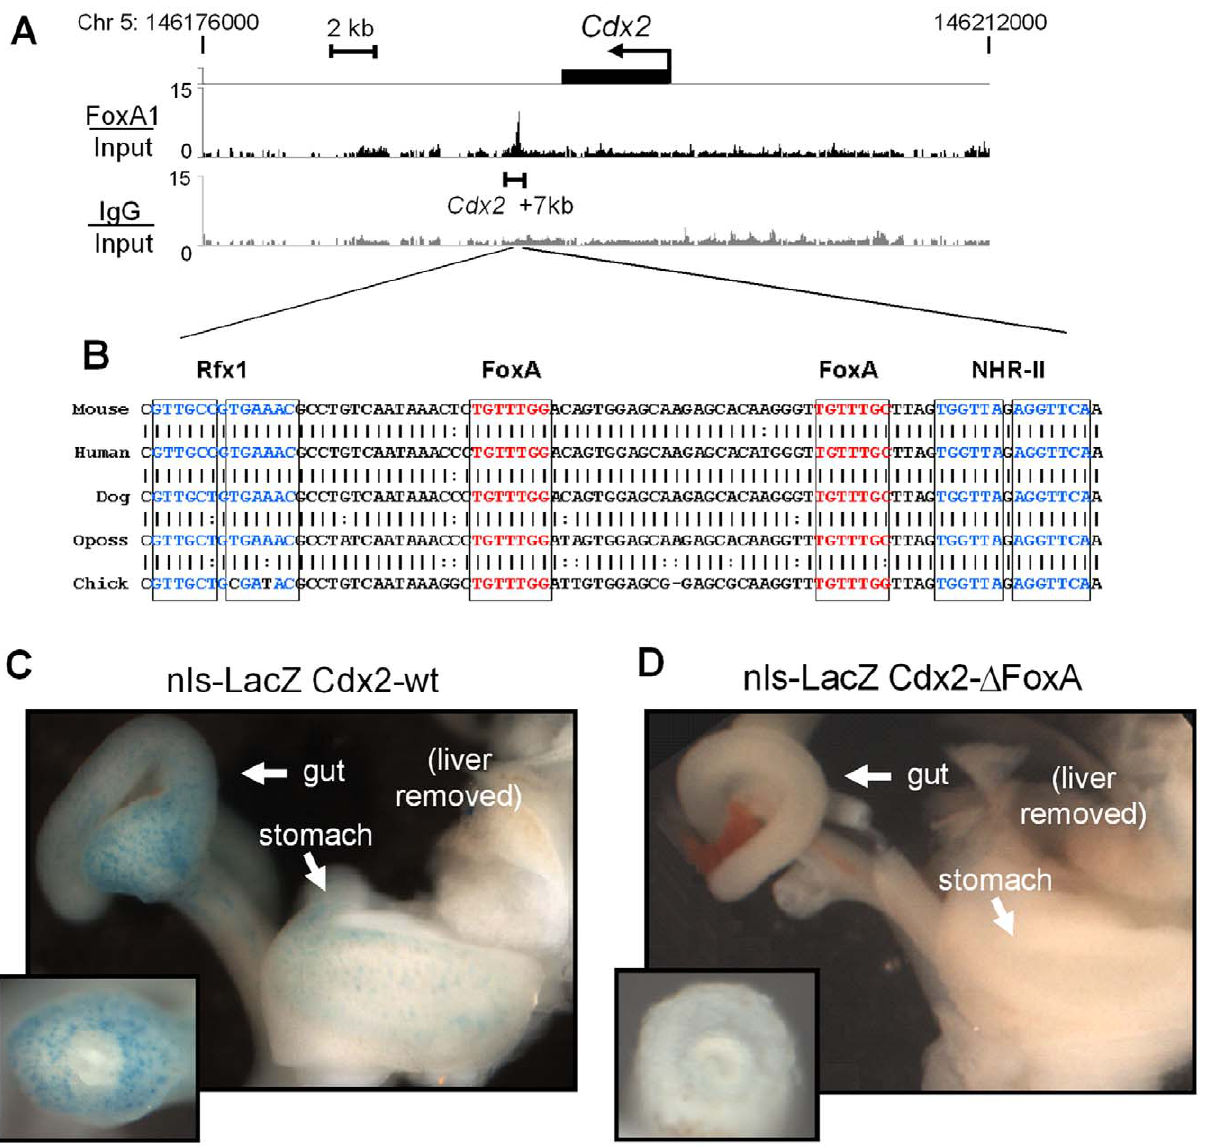
Figure 3. Novel FoxA binding site at Cdx2 . FoxA2 ChIP-chip signal at the Cdx2 locus on mouse chromosome 5. Signal from FoxA2 vs. input (black) and IgG vs. input (grey) are shown on a linear scale. Below is an expanded view of the DNA sequence of the region within ChIP-chip peak, depicting sequence conservation between mouse and chicken. Transcription factor binding sites for FoxA, Rfx, and NHR-II are indicated. (C and D) LacZ staining of nuclear- b -galactosidase reporter mice at E12.5. Embryos containing reporter driven by the wild-type Cdx2 enhancer (C) and FoxA-site mutants (D). Cross sections through hindgut (insets).